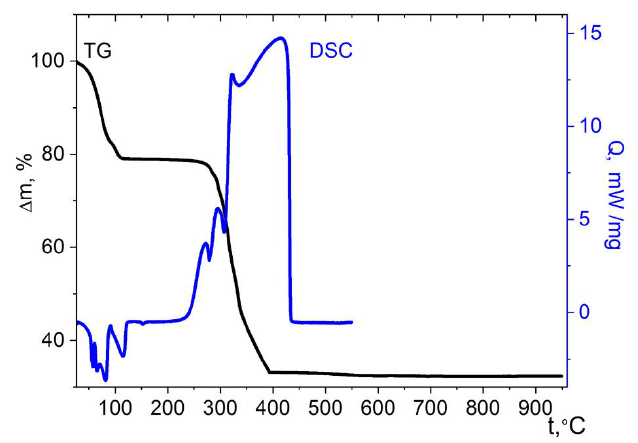
Figure 9. Thermolysis of complex 1 under air.